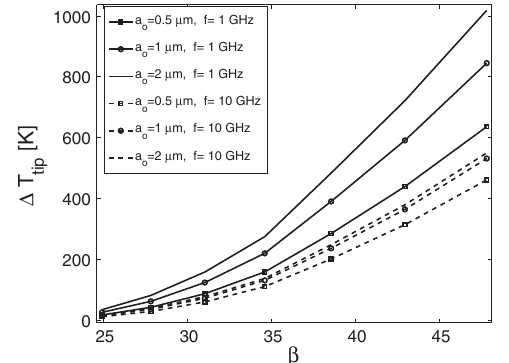
FIG. 9. The maximum change in tip temperature versus (cid:5) for various values of scaling factor a o . The background field is 300 MV = m . Dashed lines describe the 10 GHz F o ¼